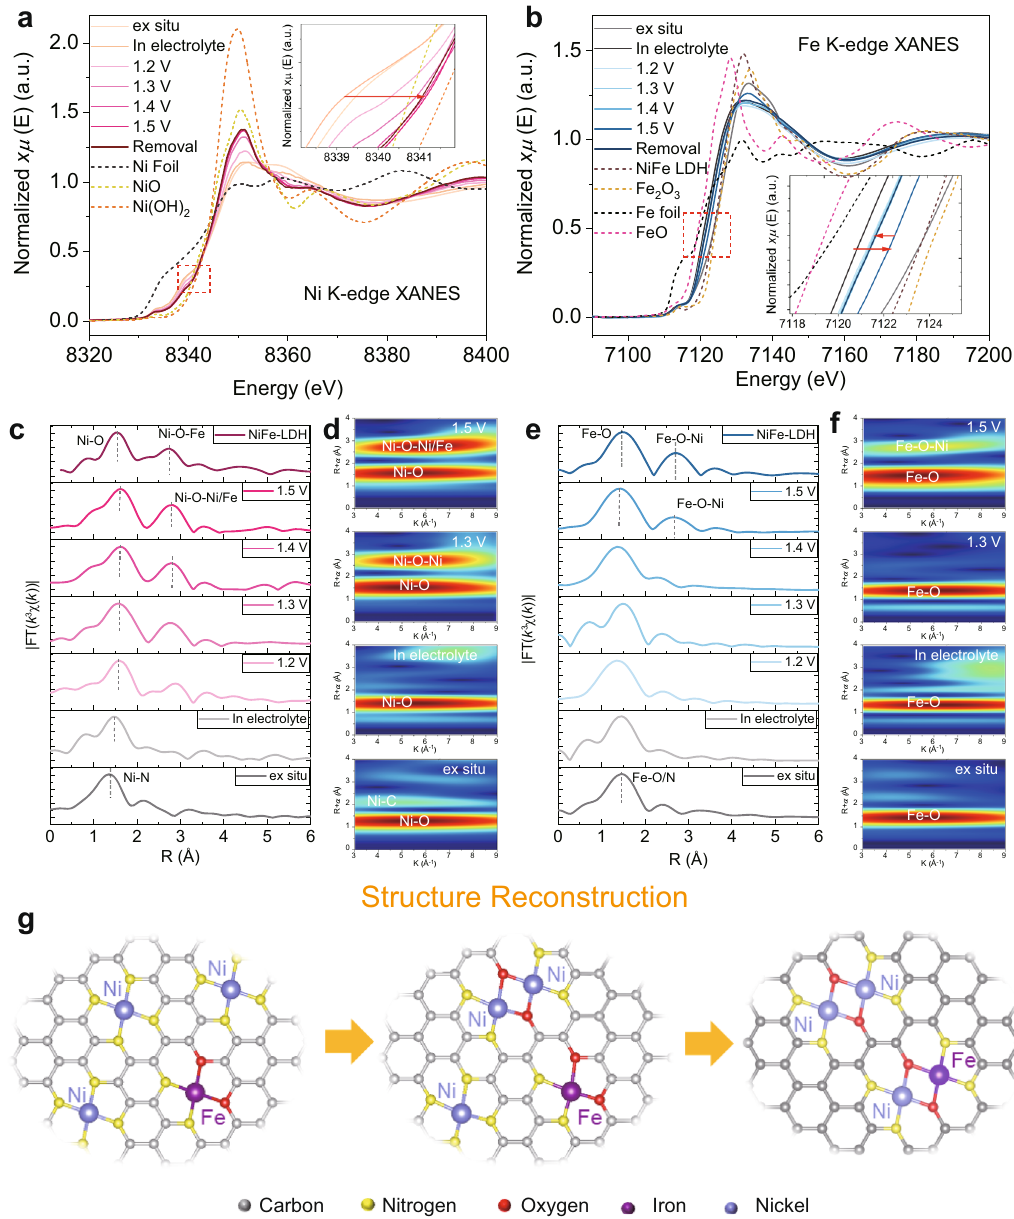
Fig. 4 In situ XAS of NiFe-CNG under OER conditions. Ni, Fe K-edge. a , b XANES and c , e FT-EXAFS spectra of NiFe-CNG under different applied potentials, and the corresponding XANES and FT-EXAFS spectra of their reference samples. d , f Extracted wavelet transforms of the k 3 -weighted EXAFS signals of NiFe-CNG under applied potentials. g Structural reconstruction of NiFe-CNG during OER from separate Ni and Fe centers to Ni-O-Fe/Ni